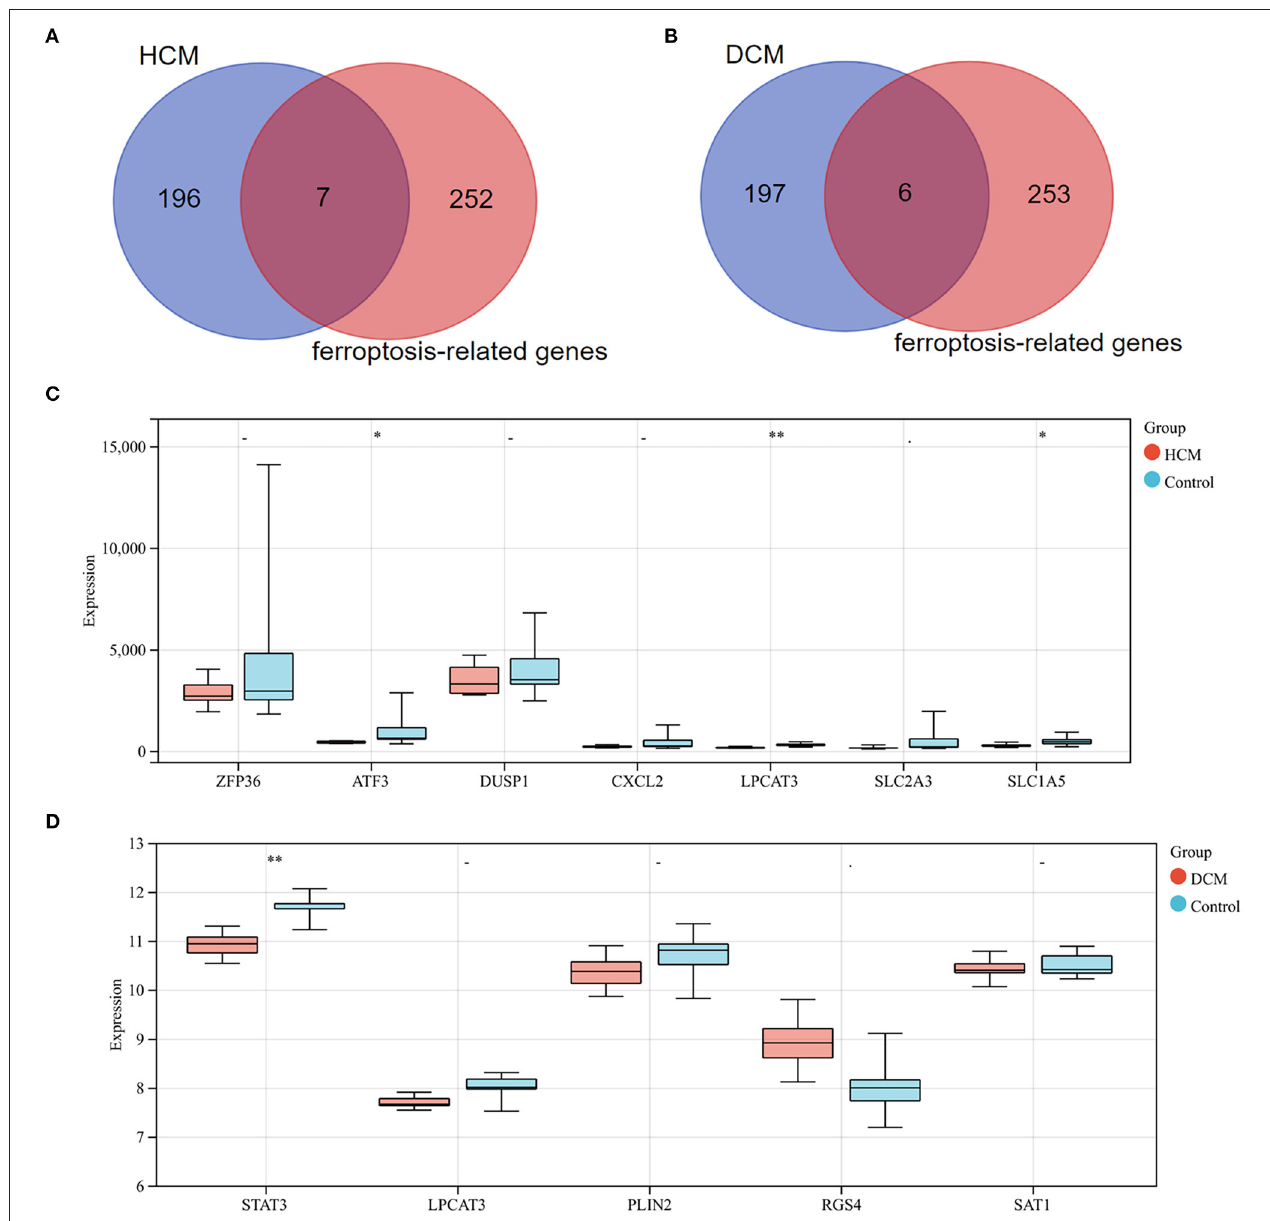
FIGURE 10 | (A) Venn diagram of preliminary ferroptosis-related DEGs in HCM. (B) Venn diagram of preliminary ferroptosis-related DEGs in DCM. (C) The expression levels of preliminary ferroptosis-related DEGs of HCM in GSE1145. (D) The expression levels of preliminary ferroptosis-related DEGs of DCM in GSE3585. * P < 0.05; ** P <